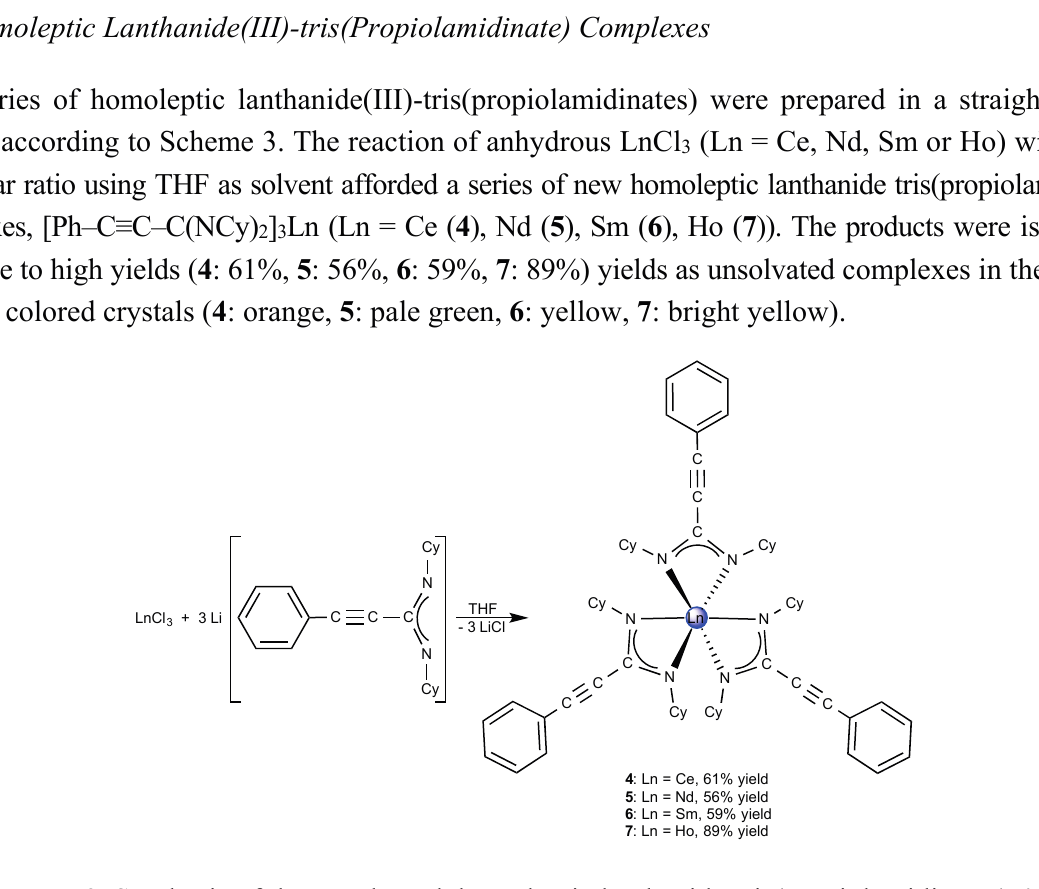
Scheme 3. Synthesis of the unsolvated, homoleptic lanthanide-tris(propiolamidinates) 4 – 7